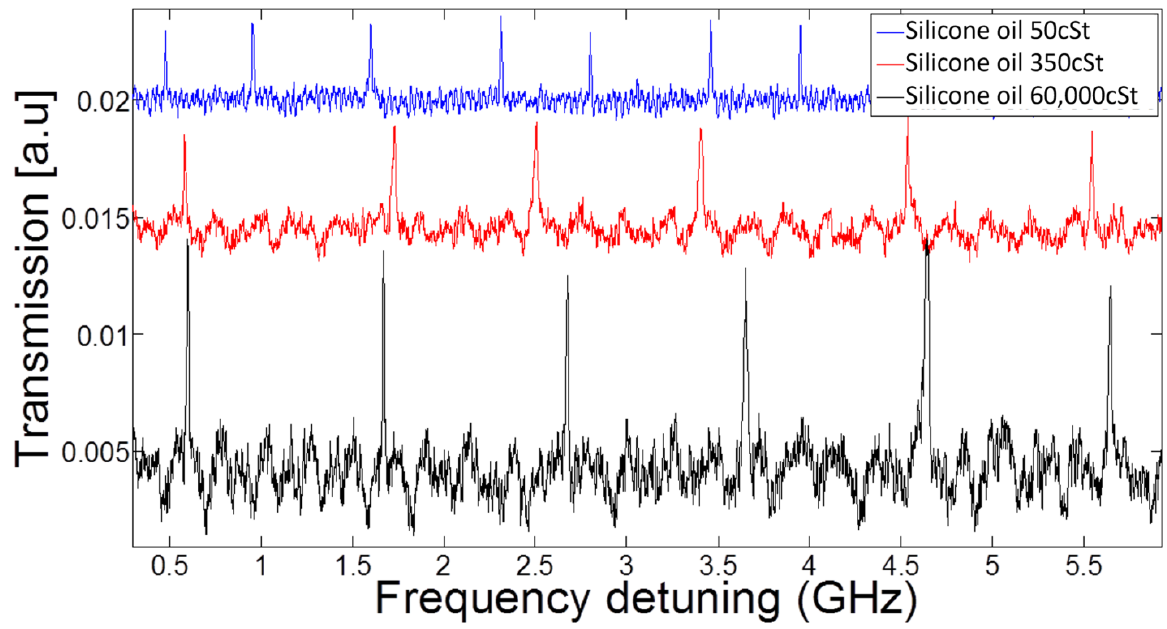
Figure 5. Viscosity comparison. Transmission vs. frequency detuning for three different viscosities of silicone oil. Laser scans at 12 GHz per second. The fluid density is 𝜌 = 960 kg/m 3, and the surface of silicone oil. Laser scans at 12 GHz per second. The fluid density is ρ = 960 kg/m 3, and the surface tension is 𝛾 = 20.8 mN𝑚 . The scan duration is 0.5 s. tension is γ = 20.8 mNm. The scan duration is 0.5